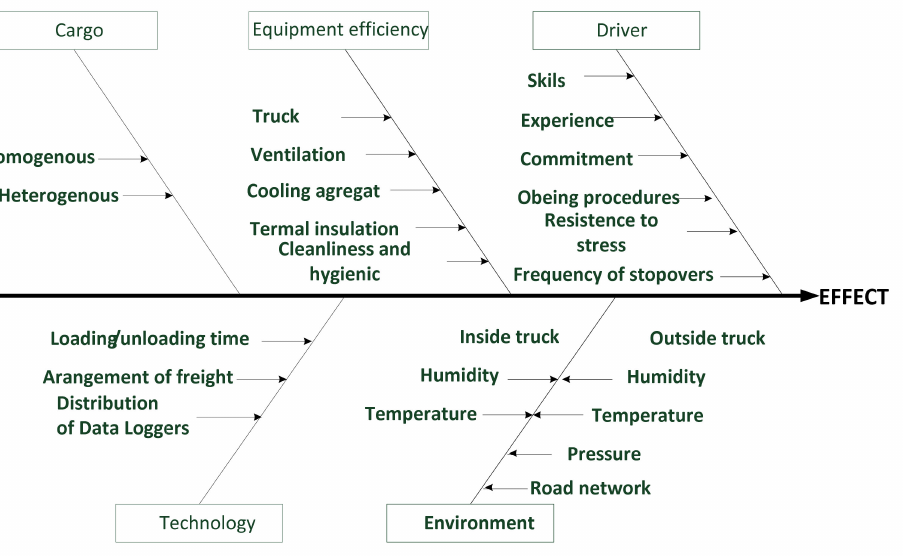
Figure 5. Cause-and-effect analysis in the transportation process on cargo temperature. Source: Figure was created as a result of a brainstorming session with CEOs of a large trade and transportation chains, retailers, quality and transportation managers and scholars (see details mentioned in the last paragraph in Section 2.2. Experimental part. It is our own